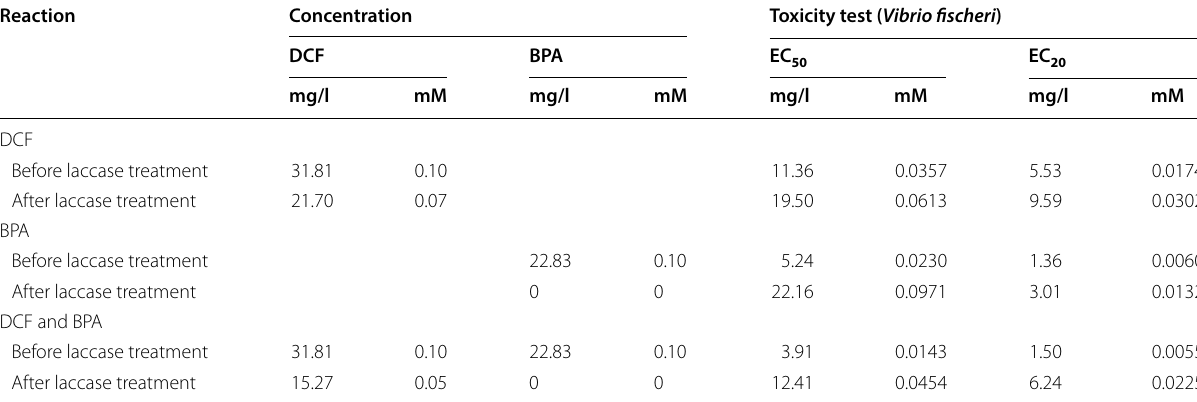
Table 2 Results of the toxicity test (test organism: Vibrio fischeri ), including concentration of DCF and BPA, before and after laccase treatment in a membrane reactor (volume: 10 l; phosphate buffer; incubation time: 4